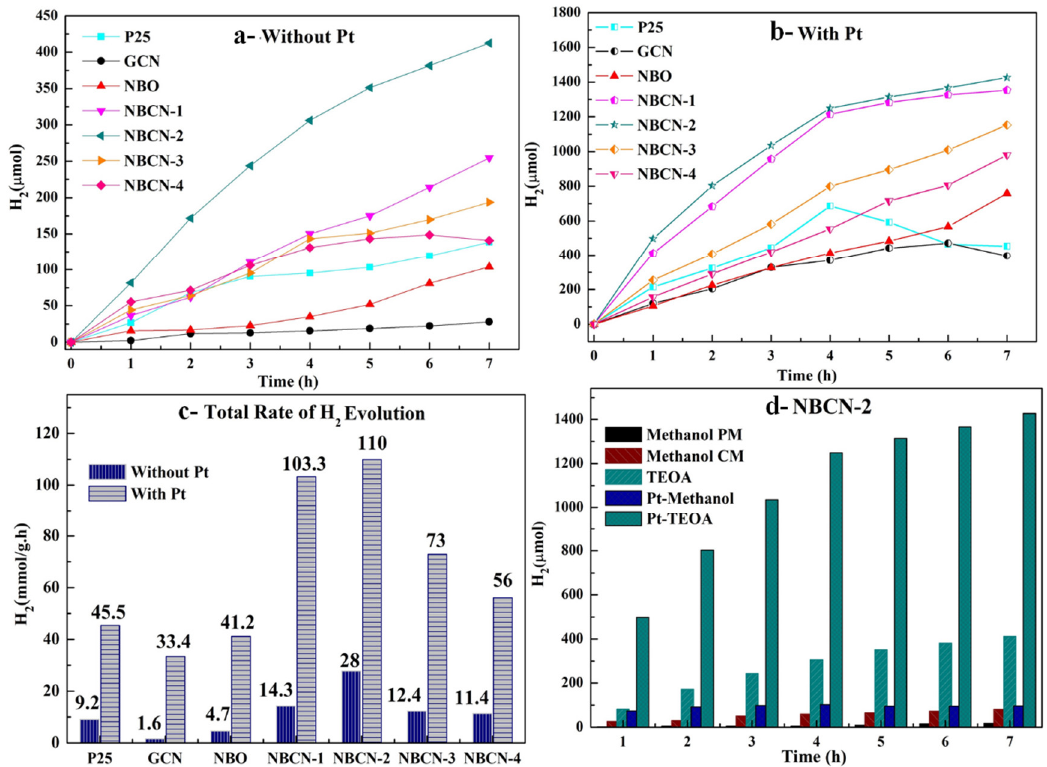
Figure 8. The photocatalytic formation of molecular H 2 of P25, NBO, GCN, NBCN-1, NBCN-2, NBCN-3 and NBCN-4: ( a ) without Pt, ( b ) with Pt deposition, and ( c ) total evolution rate; ( d ) photocatalytic formation of molecular H 2 of NBCN-2, in the presence of methanol and TEOA.